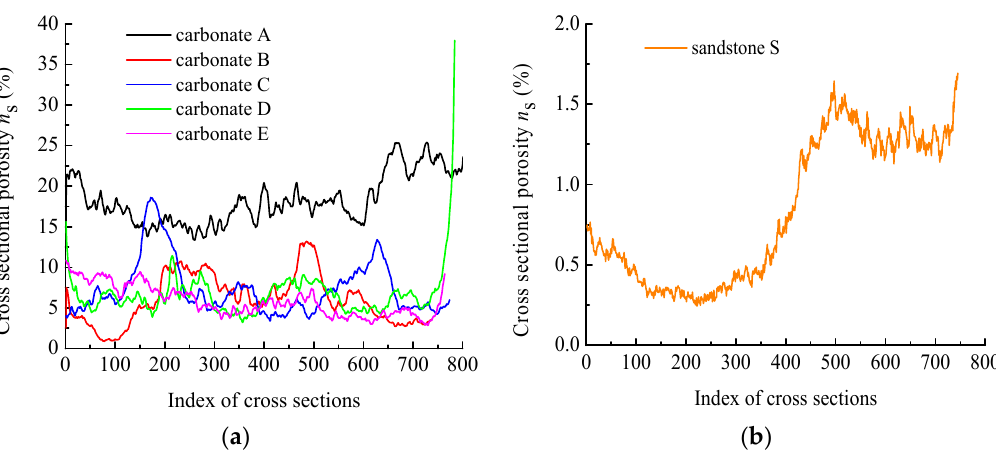
Figure 5. Distribution of cross sectional porosity along the direction of Z axis. ( a ) Carbonate. ( b ) Sandstone.